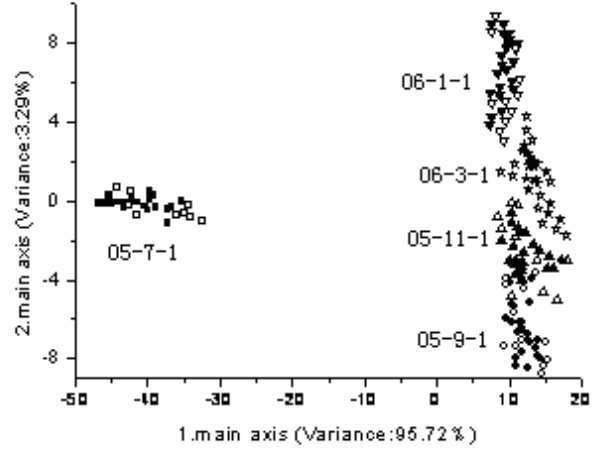
Figure 3. Discrimination and testing result of LDA based on the tea beverages.